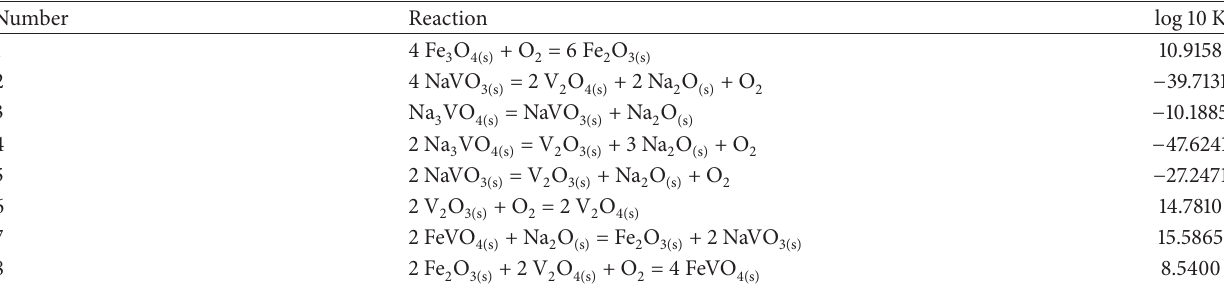
Figure 5: Cross-sectional aspect of Cr and elements distribution after corrosion test. Table 1: Chemical reactions and equilibrium constants for the Fe-Na-V-O system at 700 ∘